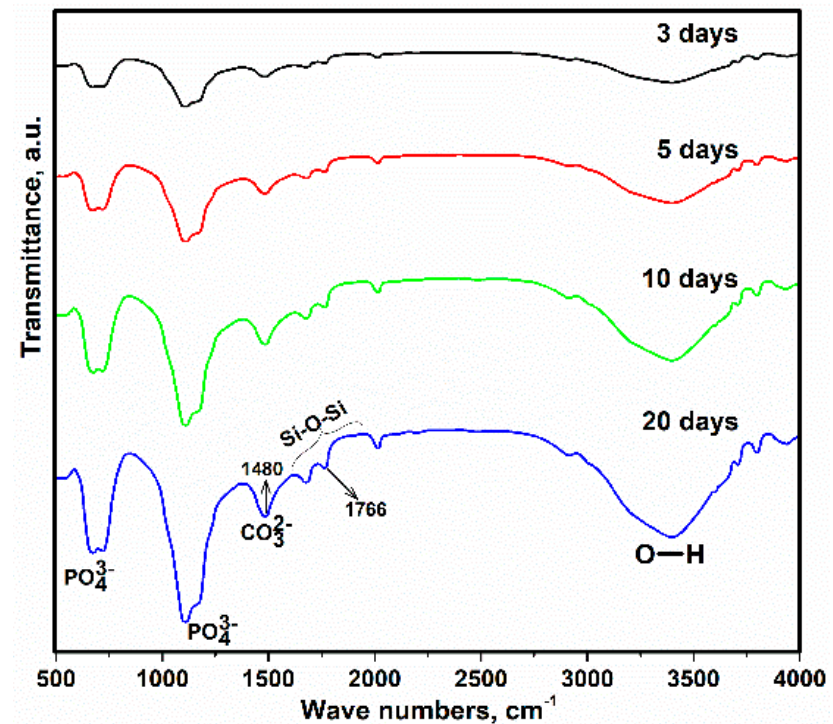
Figure 15. FTIR spectrum of immersed scaffold in SBF after 3, 5, 10 and 20 days. According to the SEM images (Figure 16) of the pulled out scaffold (after immersion), synthesis of the viscose slurry as well as the existence of porosities and utilizing hair band as a novelty were useful and effective. The rate of precipitation of HA on the surface of scaffold was very high when the porosities were filled only after 3 days of immersion (Figure 16). In addition, with this idea (utilizing hair band as a mold) the diffusion of calcium and phosphor ions from SBF into the porosities was increased. Nevertheless, needle-shaped morphology (initial morphology) of HA [72] is converted to the sphere shapes. As mentioned in [73,74], these porosities are applicable according to the size of blood cells and requirements to the big porosities for siting the blood cells into the porosities and increasing the ratio of bioactivity. Taking into account the mechanical properties of porous scaffolds, whatever the amount and size of porosity are higher and bigger, respectively, the ratio of bioactivity will be increased [75]. According to Figure 16, the precipitation of HA increased over time of immersed scaffold. Taking into account the mechanism of precipitation and preparation of HA on the surface of scaffold, the existence of HCl in SBF is caused to the increasing of precipitation of HA due to the incrassating numbers of polar groups on the surface of scaffold and increasing of ratio of absorbance [76,77]. Figure 16 shows the result of EDAX of existence of HA on the surface during the 3, 5, 10 and 20 days. The ratio of Ca/P is reported 1.71, 2.07, 1.53 and 1.64 for immersed scaffold in SBF during the 3, 5, 10 and 20 days, respectively. It is clear that after 20 days of immersion, the ratio of Ca/P reached to 1.64 and this value is closer to the ratio of Ca/P = 1.67 from natural HA [78]. According to our study, the use of in vivo tests and the fabrication of this type of scaffold with the use of the bioactive metal part to increase the mechanical properties are unexplored